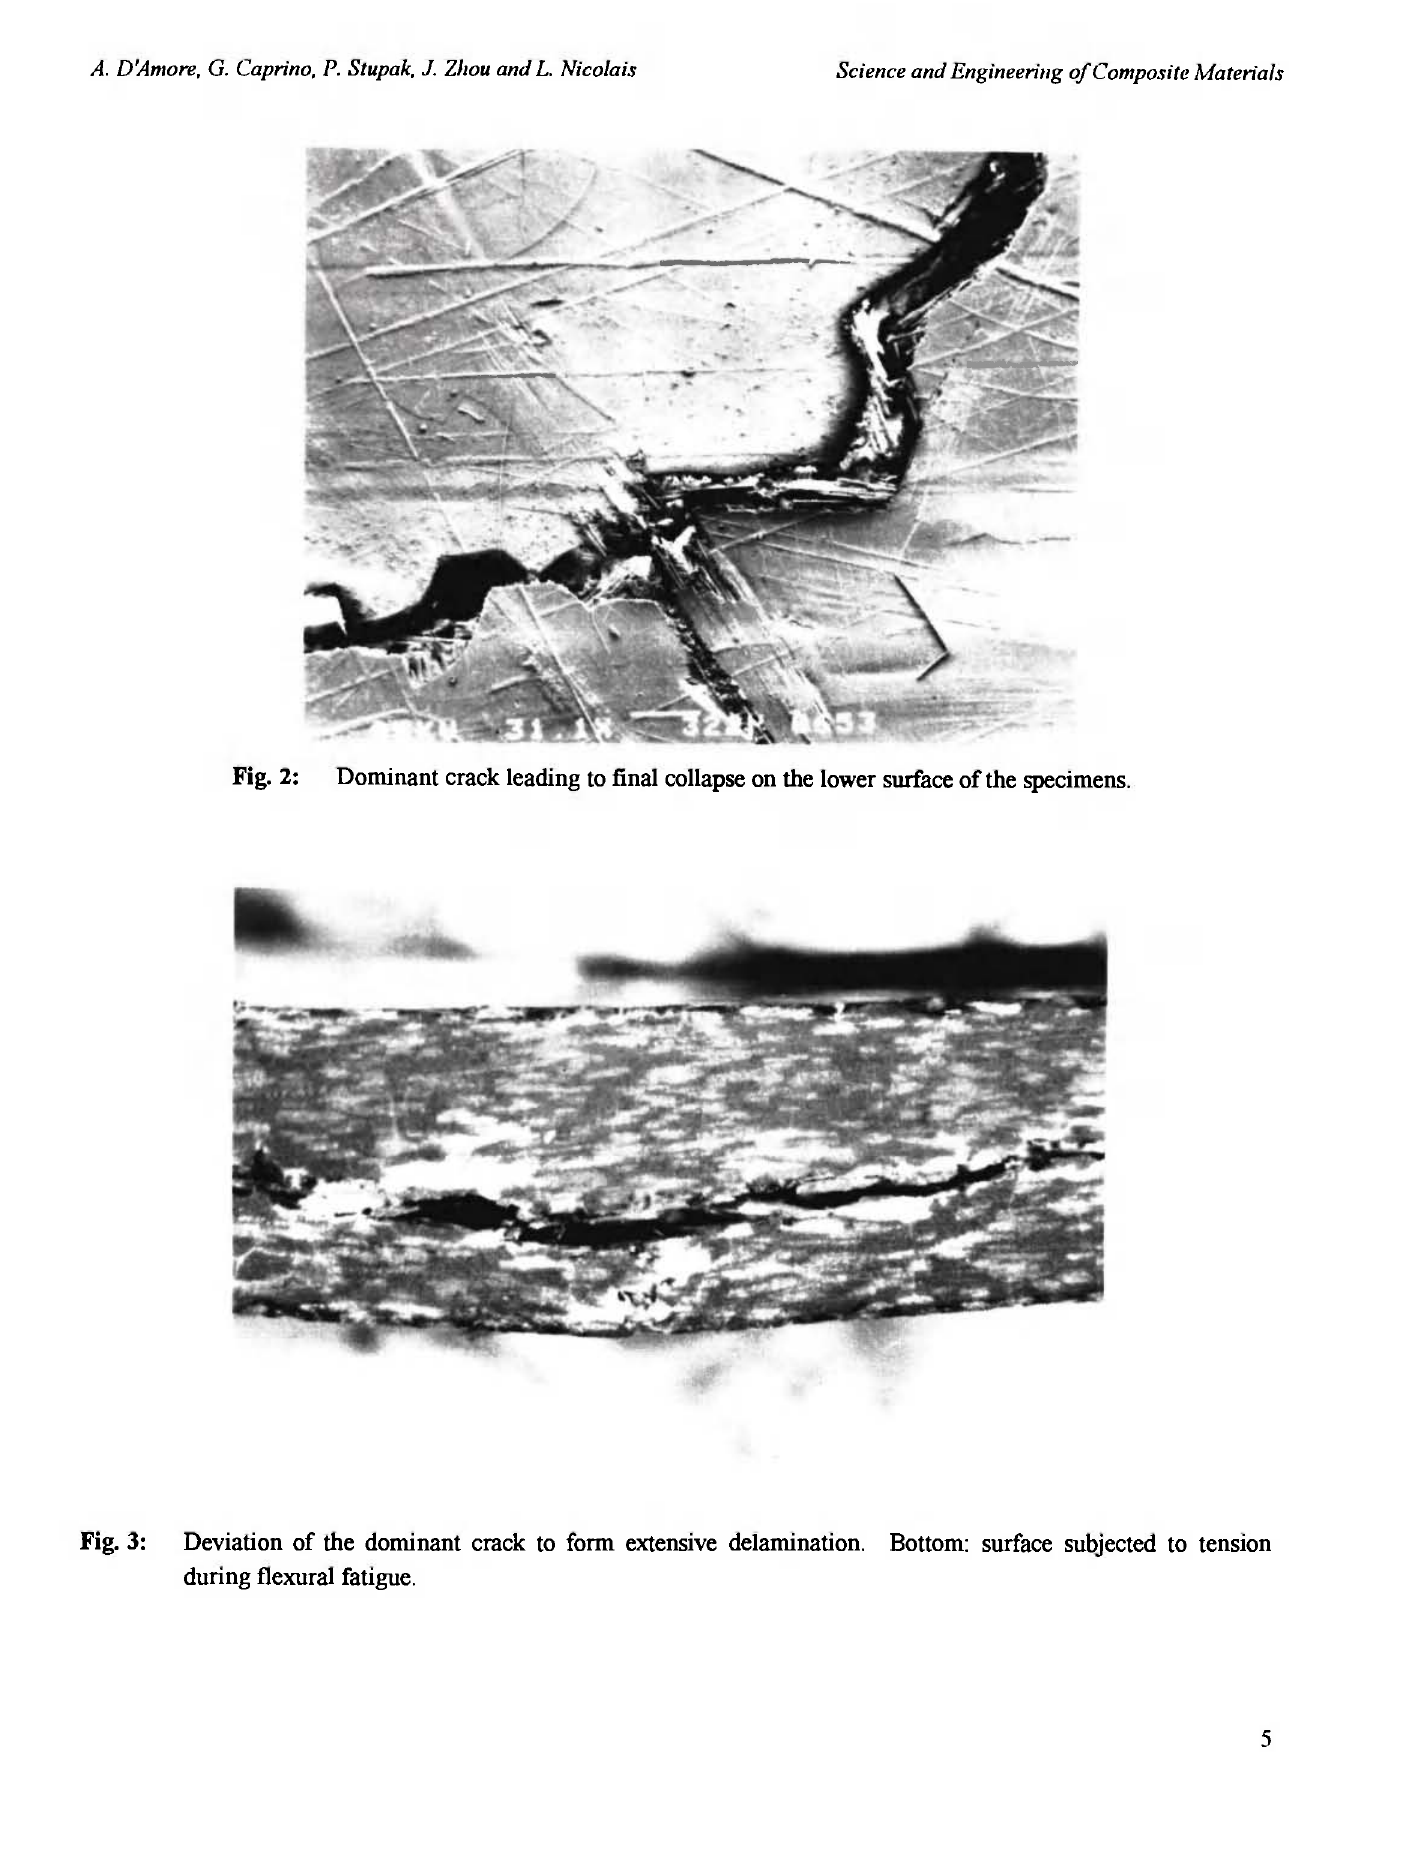
Fig. 2: Dominant crack leading to final collapse on the lower surface of the specimens.